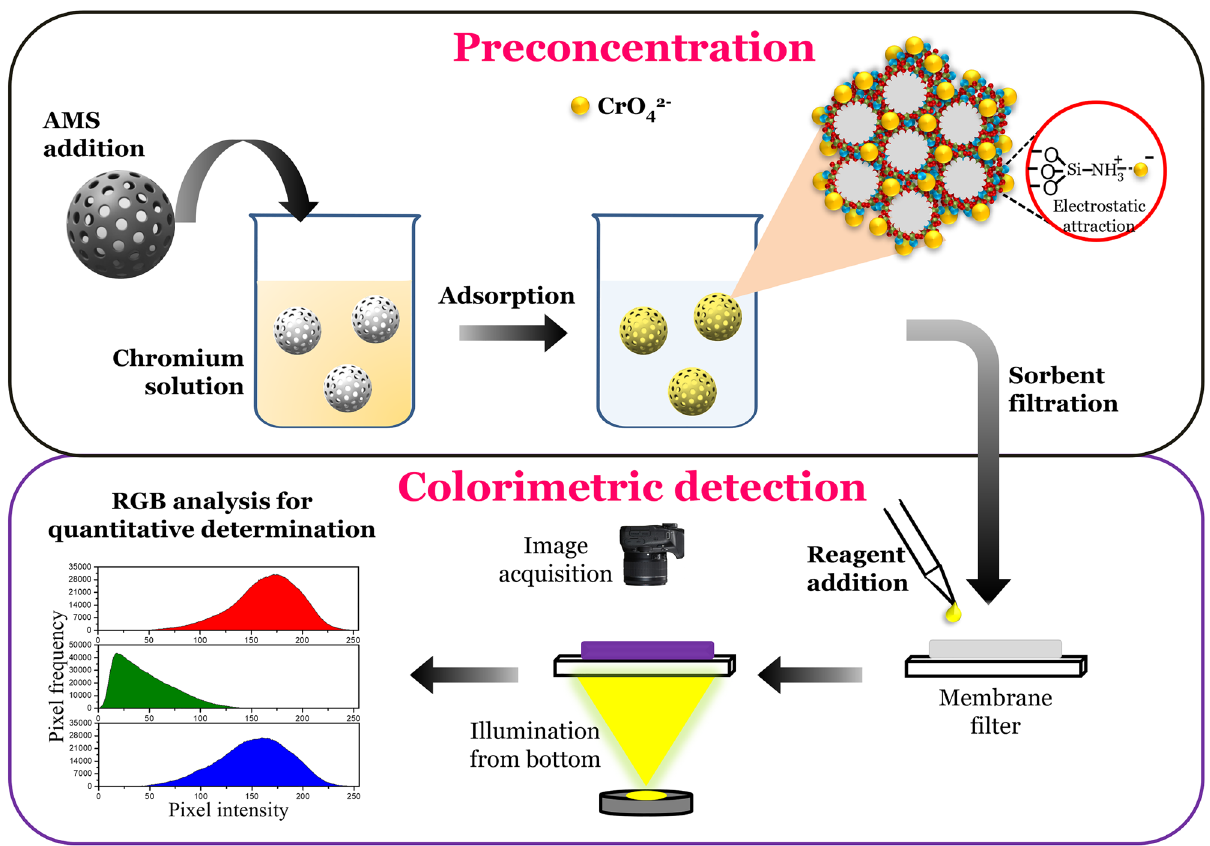
Figure 1. Schematic representation of the proposed method for chromium(VI) ions detection involving two steps: preconcentration of chromium(VI) ions using amine functionalized mesoporous silica followed by colorimetric detection on metal enriched AMS